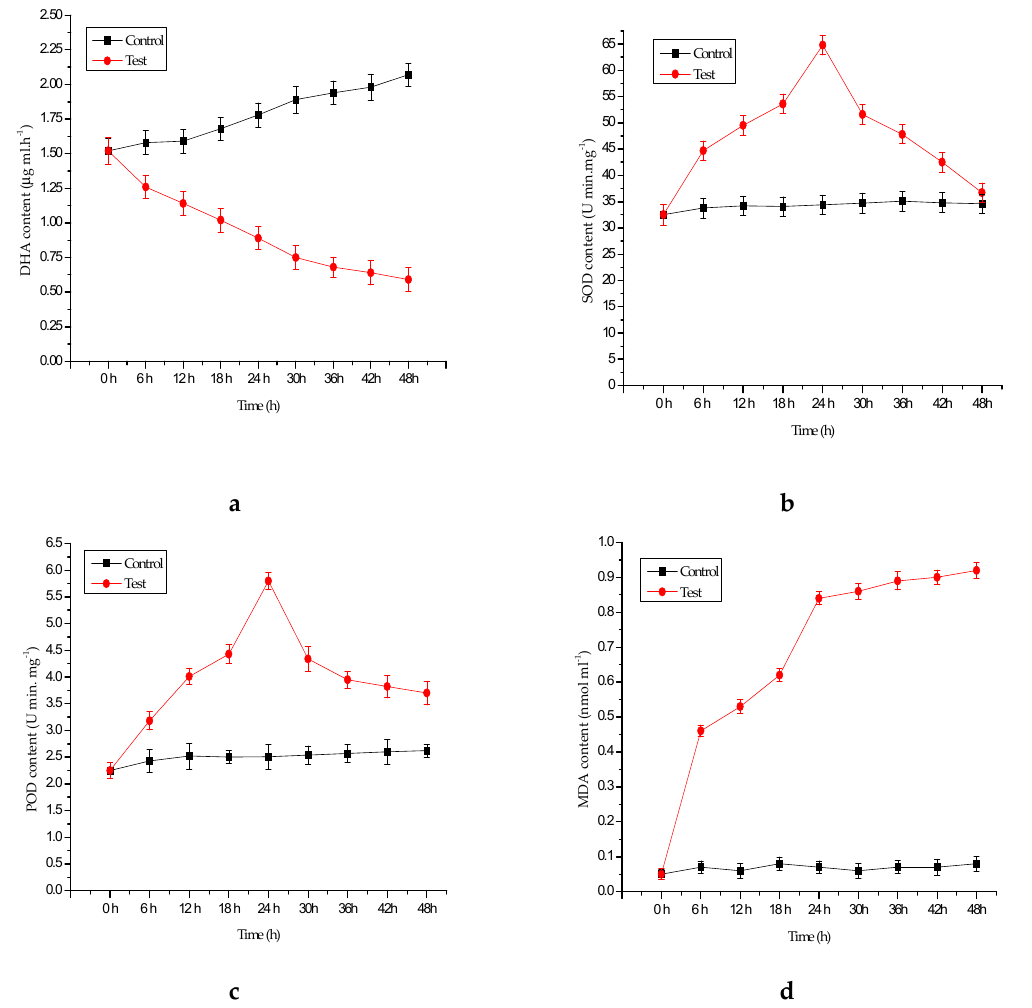
Figure 3. E ff ects of P. chrysosporium on dehydrogenase (DHA) ( a ), superoxide dismutase (SOD) ( b ), peroxidase (POD) ( c ), and malondialdehyde (MDA) ( d ) content in M. aeruginosa . Data are expressed as the mean ± SD ( n = 3).